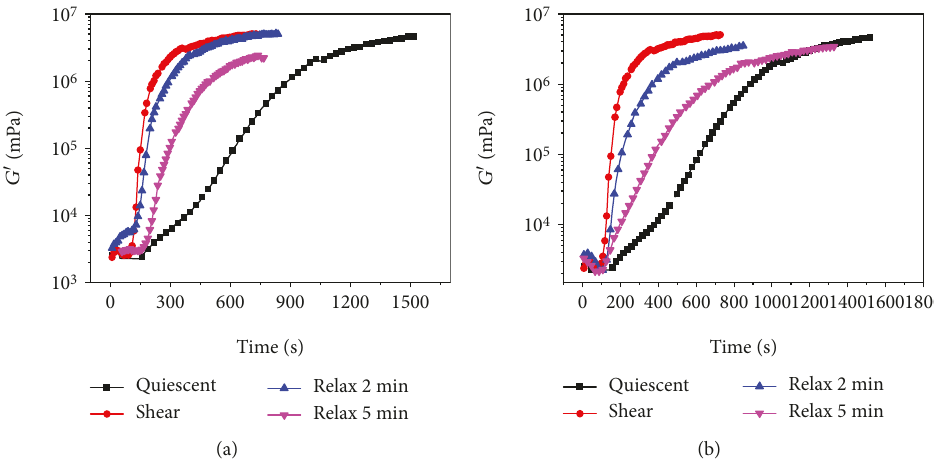
Figure 4: Evolution of the storage modulus G ′ during isothermal crystallization at 135 ° C for β -nucleated iPP agent relaxed at di ff erent temperatures: (a) T R = 180 ° C and (b) T R = 190 ° C . Flow condition: shear rate = 40s − 1 , shear time = 10 s , and T S = 170 ° C .